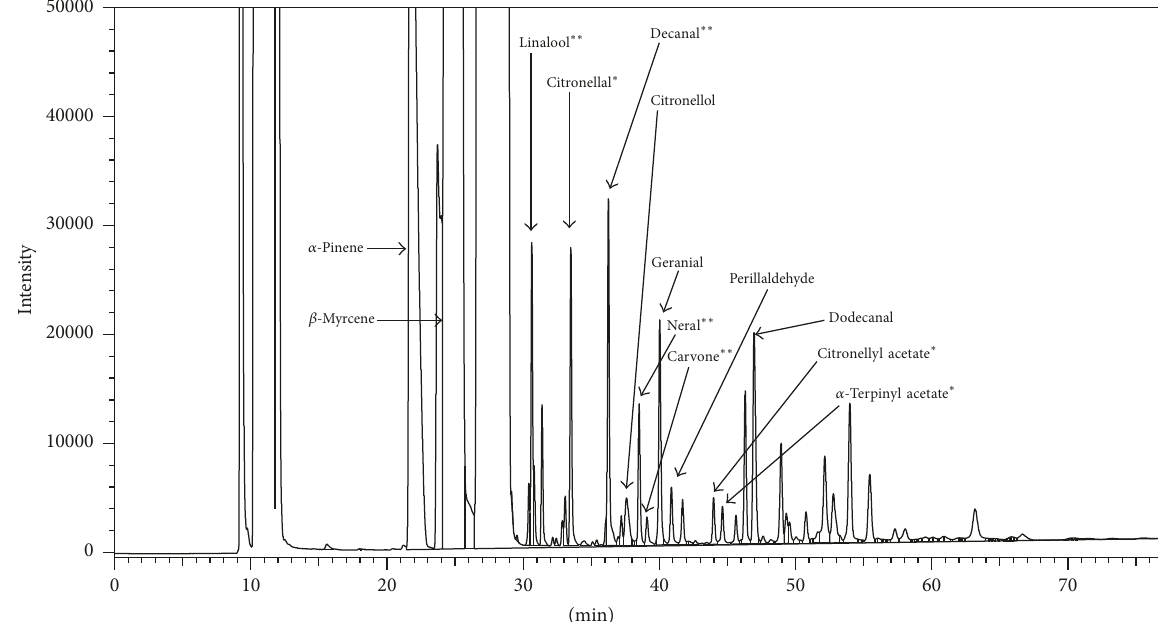
Figure 2: Chromatogram from Hamlin Early Symptomatic. Note . 2-Decenal and 2,4-decadienal are not labeled on the chromatogram as they were not detected in this sample. ∗ Compound has lower concentration compared to HEA. ∗∗ Compound has higher concentration compared to HEA.